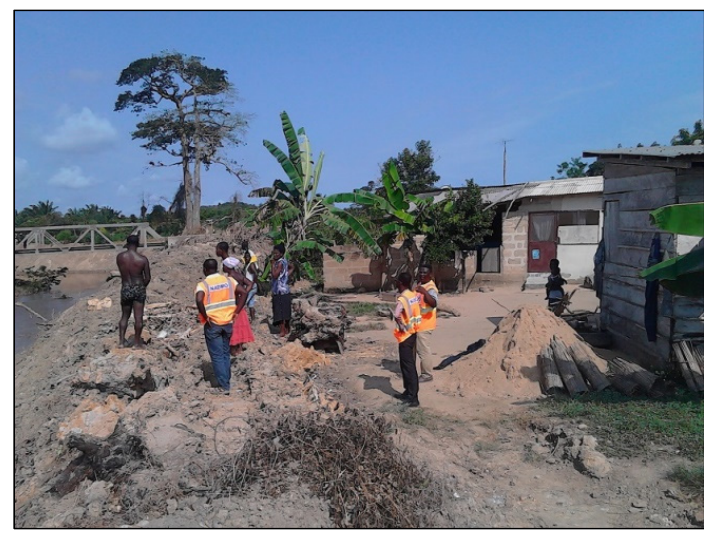
Figure 6. Dwellings located close to the Kakum River in the study area (Credit: Central Regional NADMO Secretariat, Cape Coast).